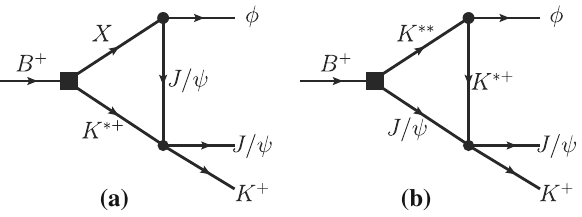
Fig. 1 B + → J /ψφ K + decay via the a XK ∗ ψ and b K ∗∗ ψ K ∗